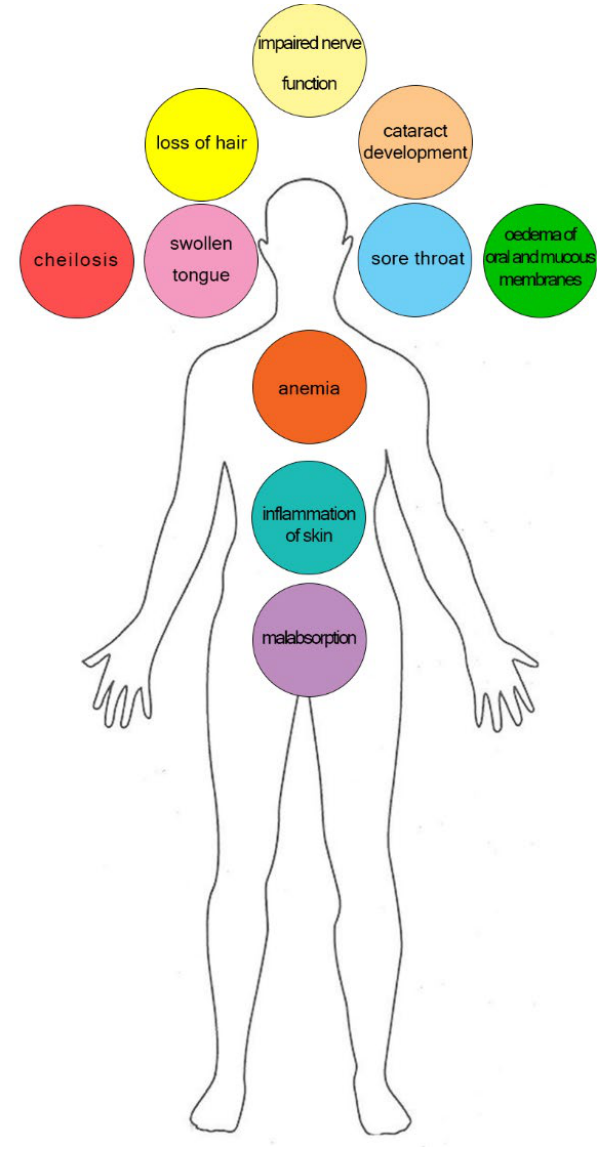
Figure 9. The most common symptoms of riboflavin deficiency.